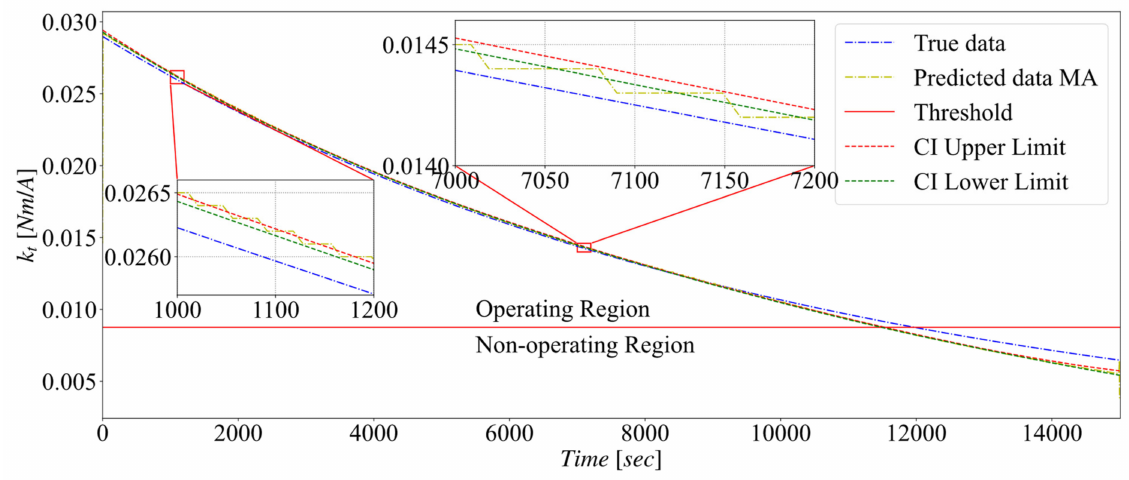
Figure 15. Confidence boundary of predicted HI parameter and RUL for hours